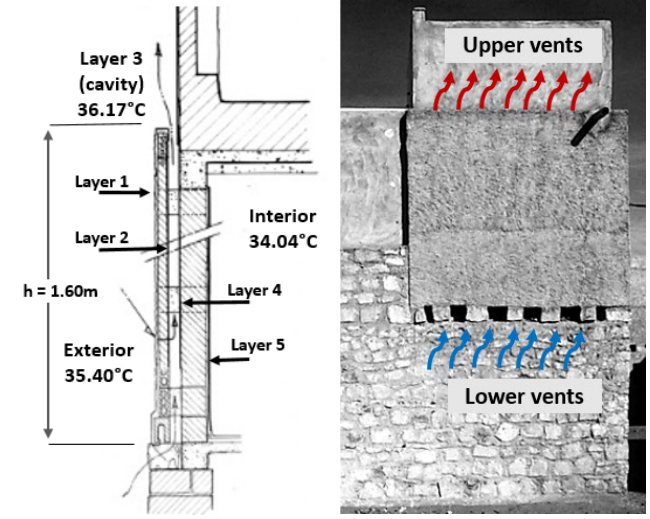
Figure 13. Air circulation inside the ventilated channel of the mask wall.